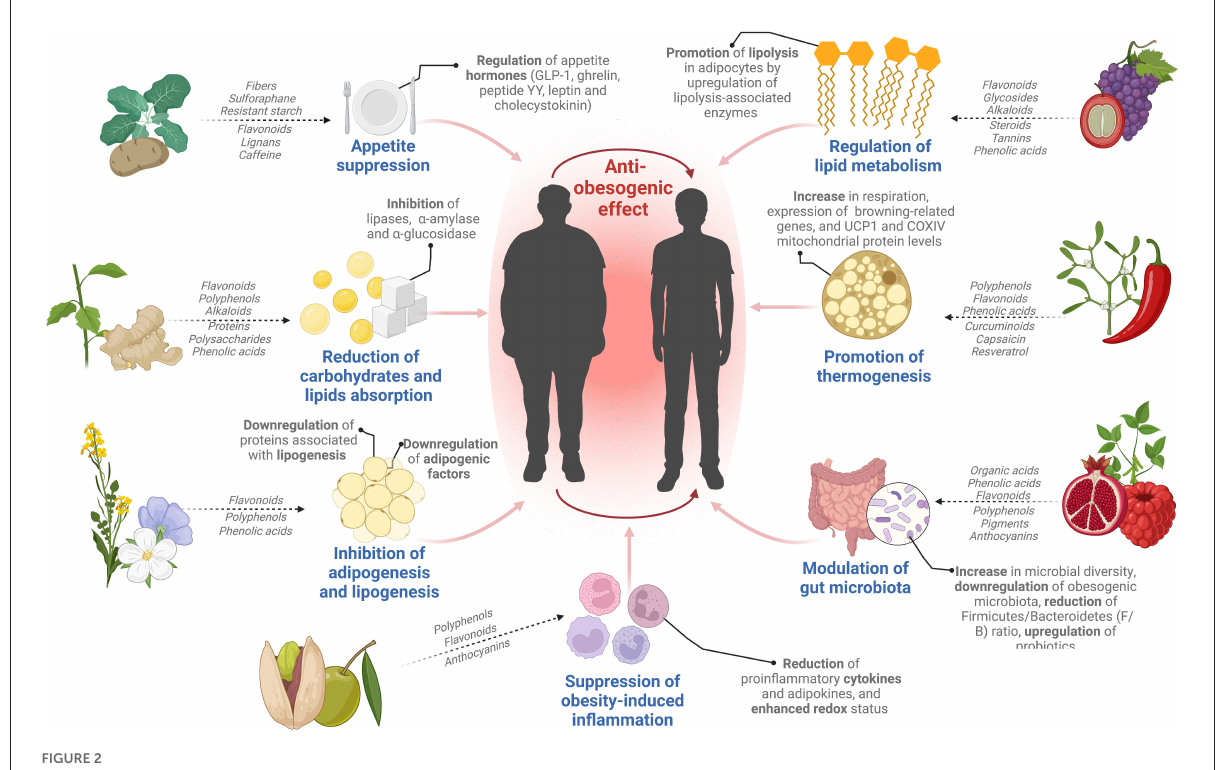
FIGURE2 Plant anti-obesogenic activity: main phytochemicals and